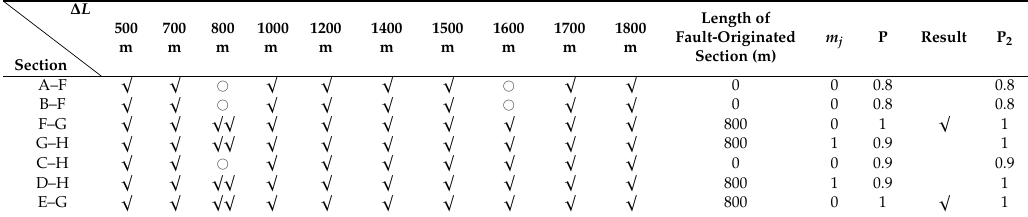
Table 2. Calculation of the probabilities based on the data measured at A.